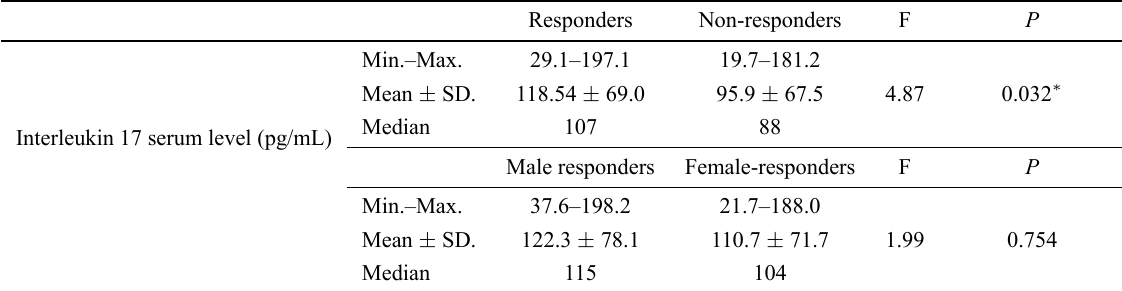
Table 5. Correlations between IL 17 serum level (pg/mL) and clinical response to PPD injection.